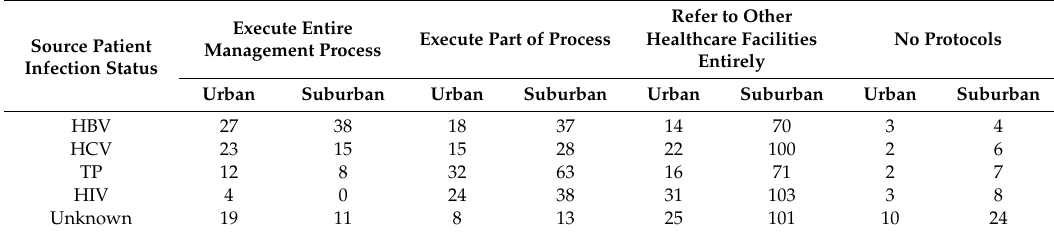
Table 2. Capability of the healthcare facilities in Beijing, China, to handle post-BBF exposure management.